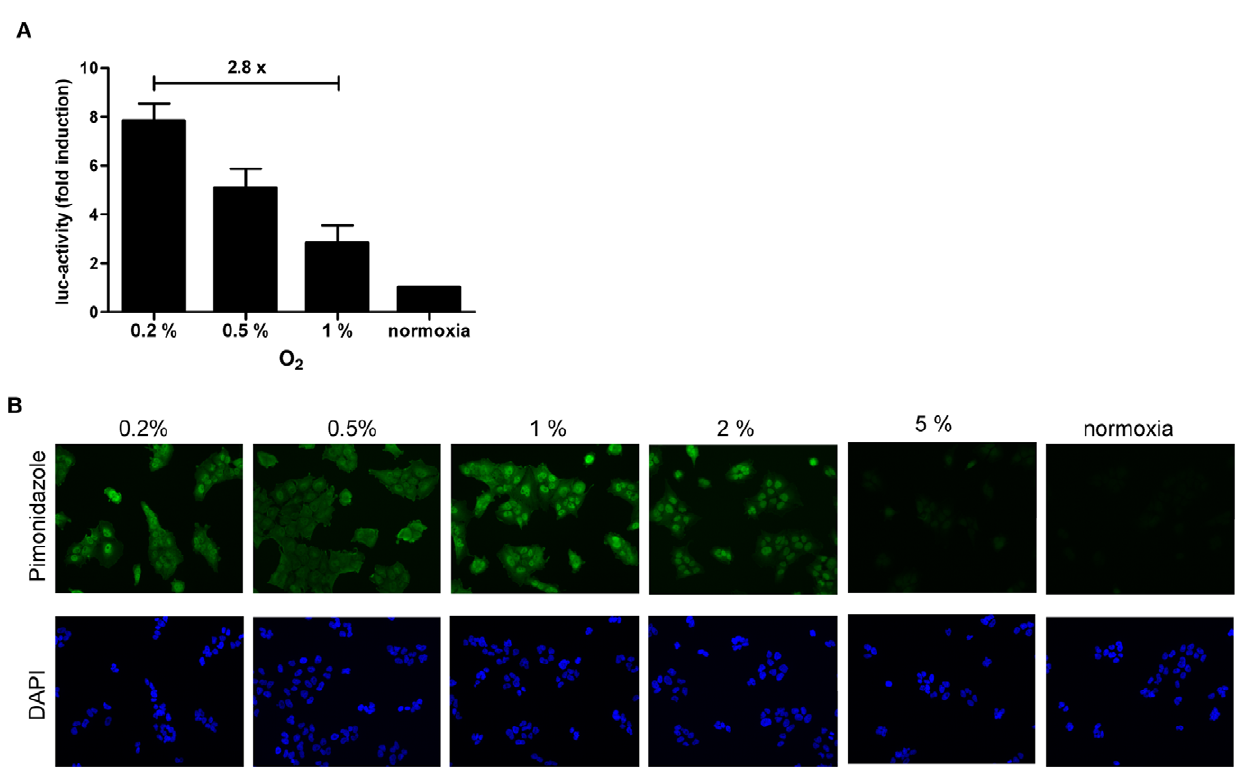
Figure 3. Differential sensitivity for low levels of pO 2 by ODD-luciferase and pimonidazole. (A) Luciferase activity in A549 ODD-Luc cells was determined after cellular incubation for 8 hours at different levels of hypoxia and normoxia. Error bars represent mean 6 SE. (B) Detection of pimonidazole accumulation in A549 cells incubated at different levels of hypoxia and normoxia. Images display immunocytochemistry staining of pimonidazole and DAPI for nuclear staining (magnification, 6